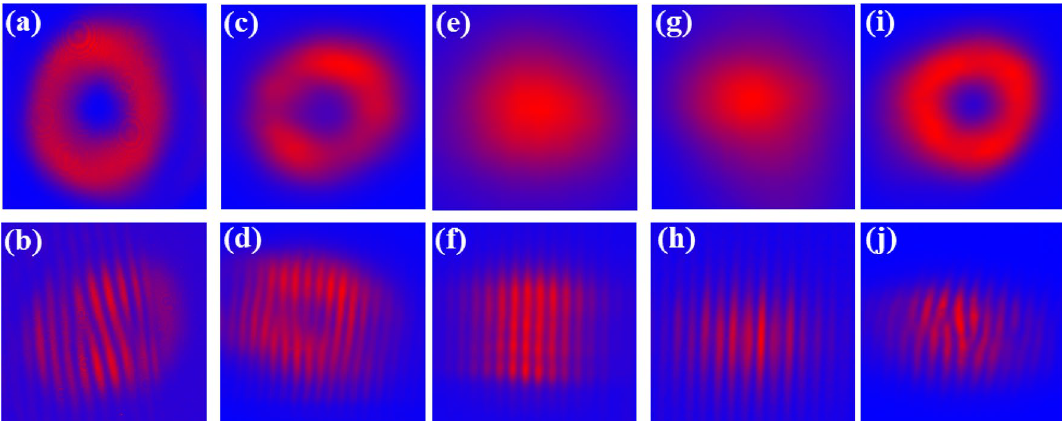
Figure 1. ( a ) Spatial form and ( b ) self-referenced fringes of the pump beam. ( c ) Spatial form and ( d ) self- referenced fringes of the signal output (1.535 µm), ( e ) spatial form and ( f ) self-referenced fringes of the idler output (3.468 µm) obtained in the low-Q cavity configuration. ( g ) Spatial form and ( h ) self-referenced fringes of the signal output (1.535 µm), ( i ) spatial form and ( j ) self-referenced fringe of the idler output (3.468 µm) obtained in the high-Q cavity